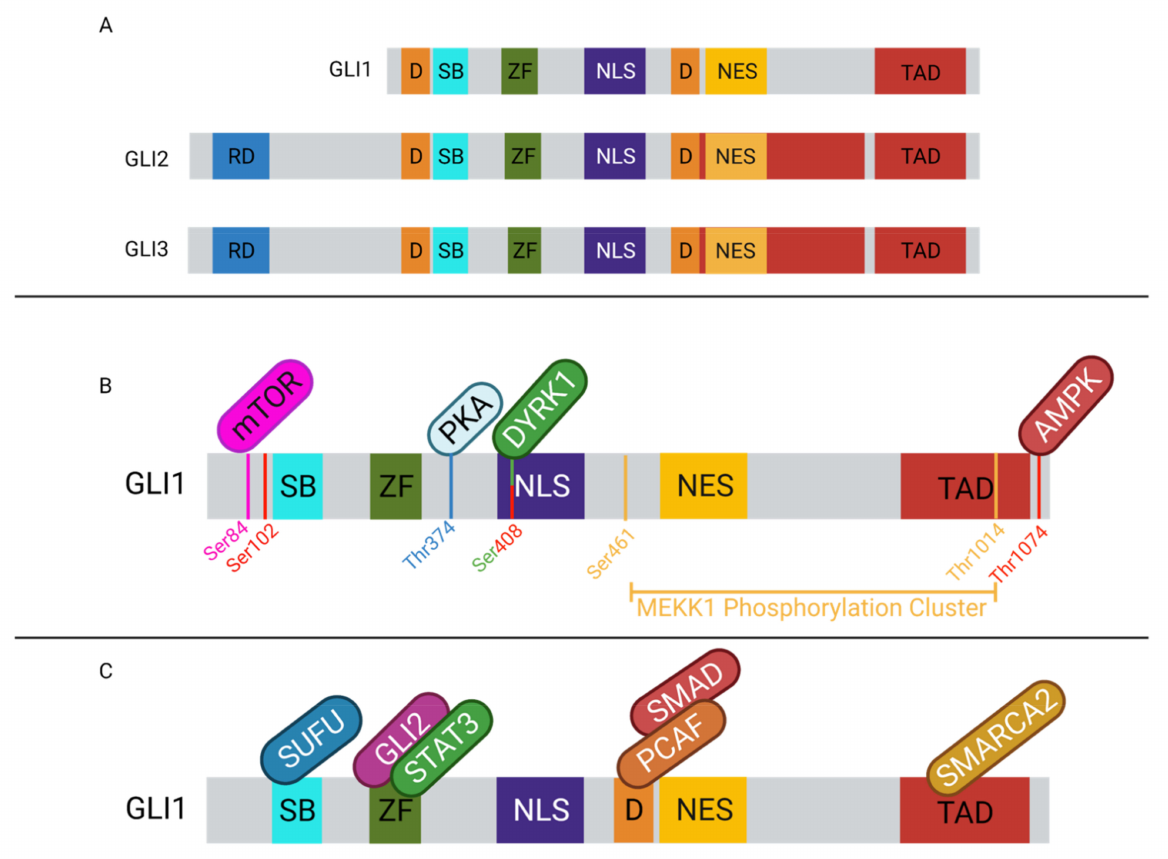
Figure 2. GLI1–3 regulatory and protein-interacting domains, post-translational modification sites, and interactions with co-regulators. ( A ) GLI1–3 proteins and their relevant regulatory sequences and protein-interacting domains. RD (blue) represents the repressor domain, D (orange) represents degron sequence, SB (cyan) represents the SUFU binding site, ZF (green) represents the zinc finger domain, NLS (purple) represents the nuclear localization signal, NES (yellow) represents the nuclear export signal, and TAD (red) represents the transcriptional activator domain. ( B ) GLI1 protein amino